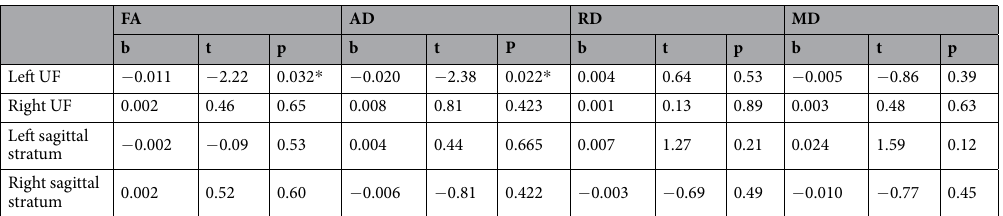
Table 4. Linear regression of twin differences in neuroimaging measures on twin differences in anxiety a . a Linear regression includes the covariates of age and sex of twin